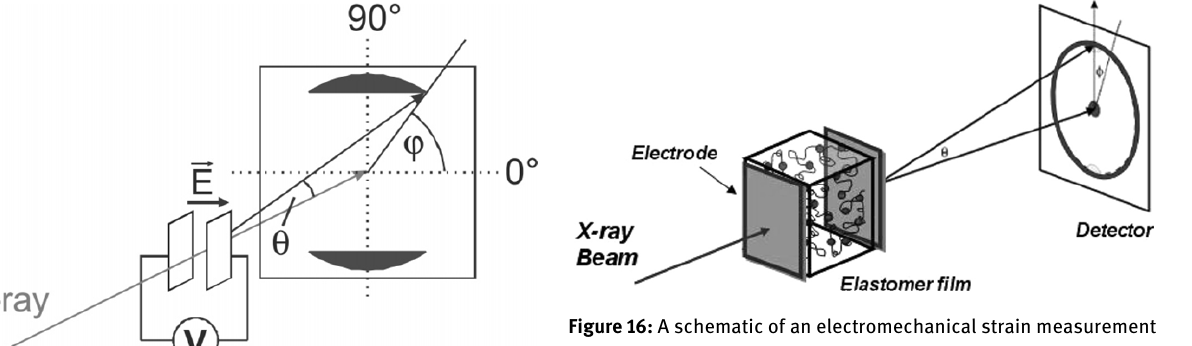
beamlines at the European Synchrotron Radiation Facility.